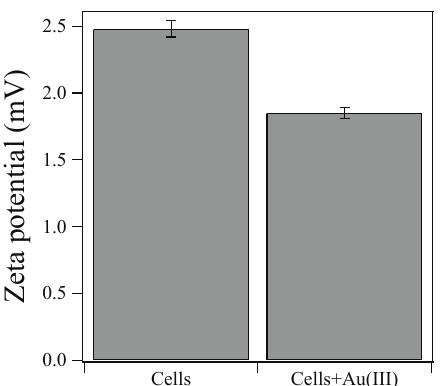
Figure 2. Zeta-potential measurement of Ac. aromatica cells at pH 2.5, with or without mixing with 10 mg / L Au(III).